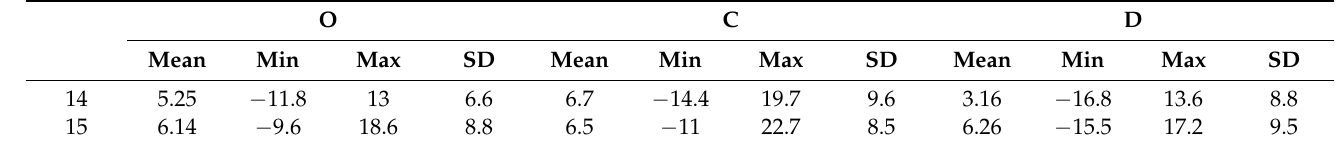
Table 5. Descriptive statistics of temperature at each test point on the 14th and 15th ( ◦ C).